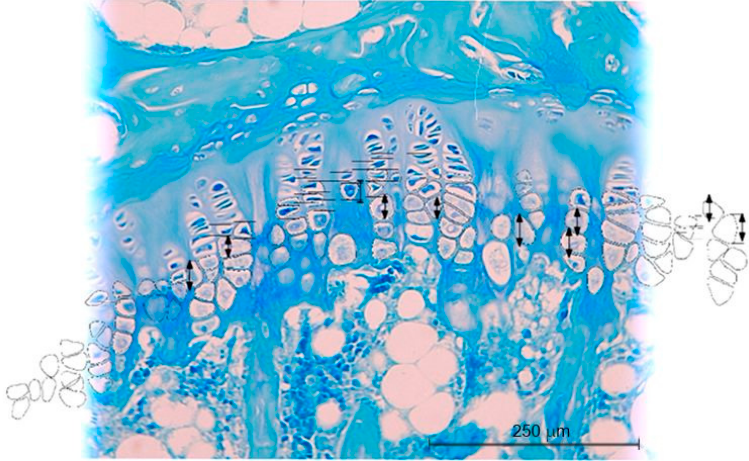
Figure 10. Scheme of chondrocyte height measurement. Methyl Blue staining 200×.